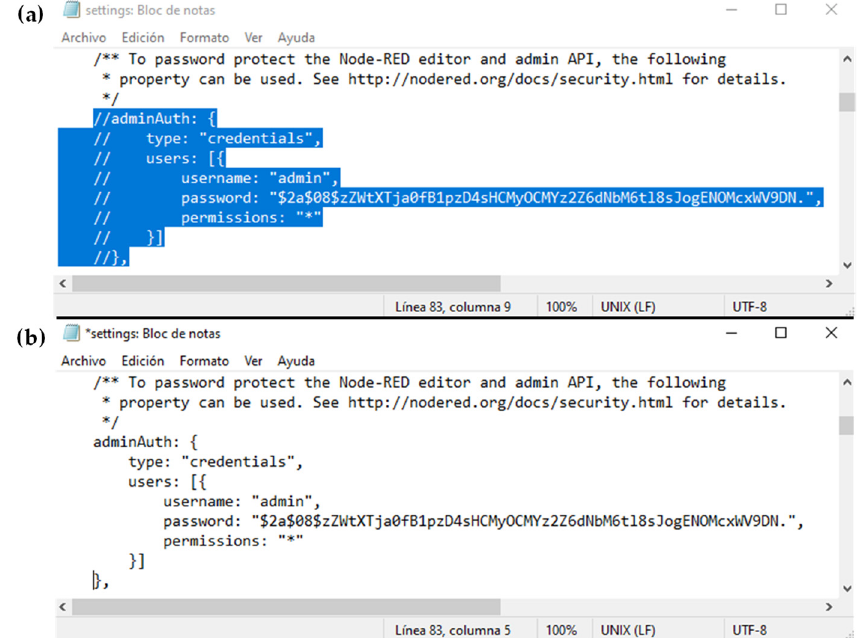
Figure 2. ( a ) Node-RED security disabled; ( b ) Node-RED security